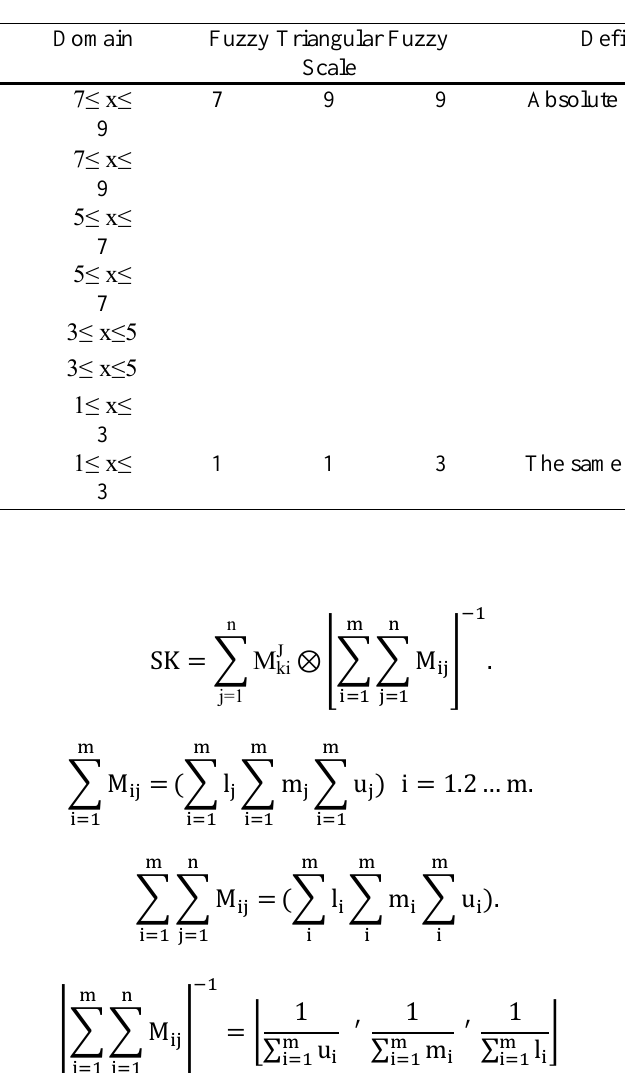
Table 4. Fuzzy ratio scale